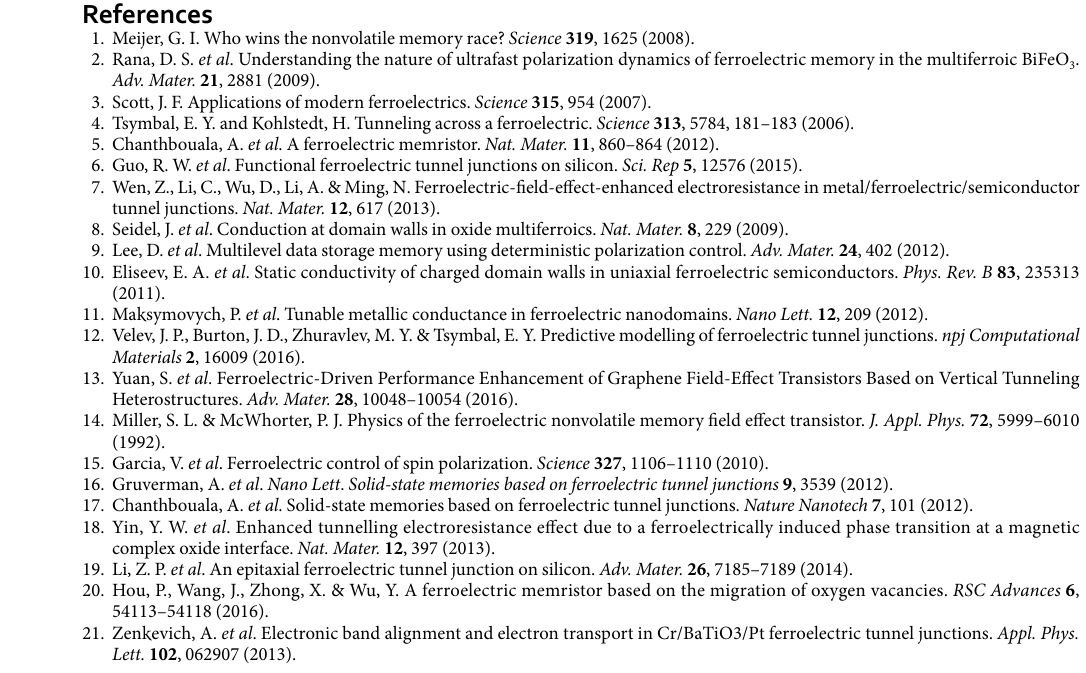
voltage pulses are much easier than those in the former reports 7–19 . In especial, the multilevel data ferroelectric storage memory is integrated with silicon technology and cheap for electronic devices, which shows strong prom- ise for future high storage density nonvolatile ferroelectric memory applications. Methods Device preparation. Different thick polycrystalline BFO films have been grown by laser molecular beam epitaxy (LMBE) on As-doped Si substrates. During deposition of the BFO layer substrate temperature was main- tained at 650 °C with chamber oxygen pressure kept at 18 Pa. A SiO x layer was formed because of oxygen diffusion during the BFO film deposition. The samples were cooled down to room temperature in oxygen atmosphere at 38 Pa. Pt dot electrodes were fabricated by d.c. sputtering through a shadow mask about 100 μ m in diameter at room temperature. Electrical characterizations. The film thicknesses have been measured on Filmetrics model F20-UV and F50-UV. Controlled ferroelectric barrier heights have been written using an Agilent B1500A semiconductor device analyzer by applying voltage pulses, and the I - V measurement characteristic also have been measured on it. The topography of different thick BFO layers on As doped silicon wafers have been performed using an Atom Force Microscopy (AFM). And the piezoresponse AFM images were performed using the AFM with a conductive AFM tip. Cross-sectional TEM image of BFO/SiO x /Si heterostructure has been performed using Transmission Electron Microscope (TEM).